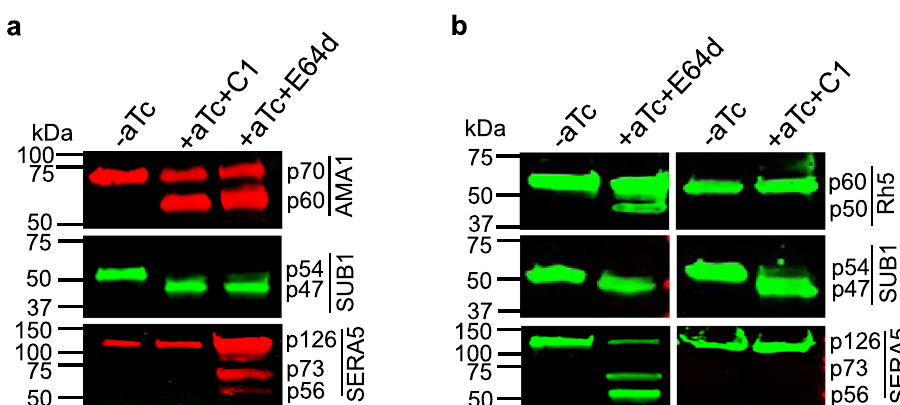
Fig. 7 | PM X cleaves microneme substrates intracellularly, while rhoptry substrate cleavage is mediated in a post-secretion manner. a , b PM X apt para- sites were grown in presenceor absence ofaTc to the schizont stage. At44h post invasion, eitherC1 (1.5 μ M) orE64d(10 μ M)wasadded tothe+aTc culturesfor6h before harvesting. Samples were blotted assess the cleavage of either AMA1